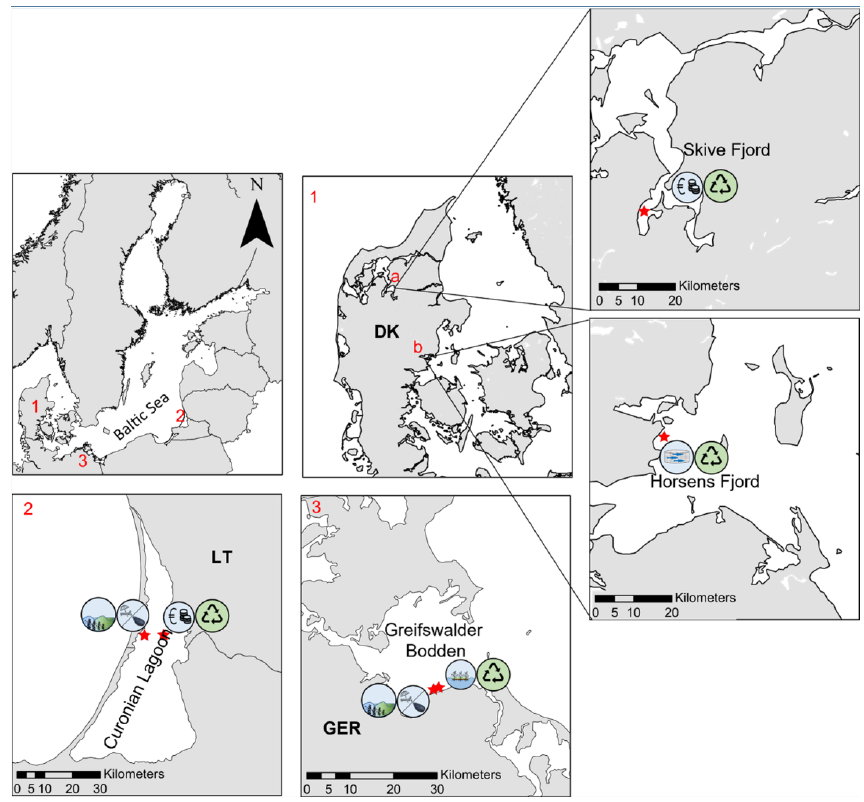
Figure 3. Different scenarios and their sites (five-pointed star), which were assessed in different ESAs. (1) Two mussel farm scenarios in Danish coastal waters: (a) commercial mitigation farm in the Skive Fjord vs. (b) the IMTA approach in the Horsens Fjord; (2) two mussel farm scenarios in the Curonian Lagoon: commercial mitigation farm vs. beach mussel farm; and (3) beach mussel farm scenario vs. floating macrophyte islands in Greifswalder Bodden.